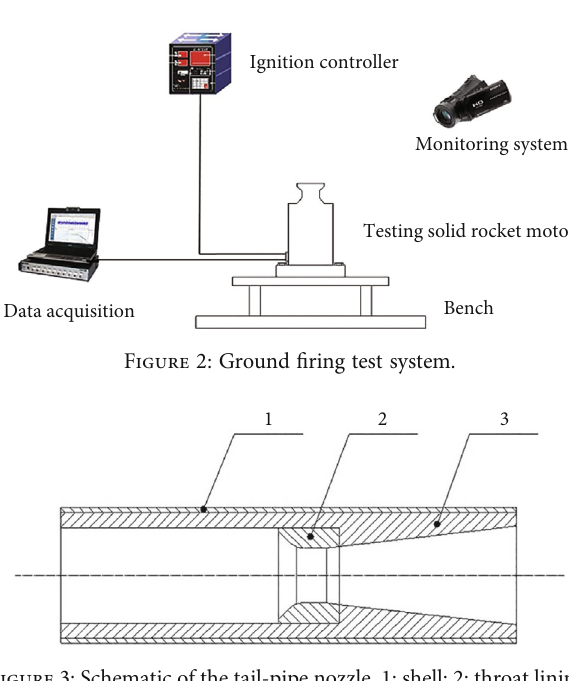
Figure 1: The original photograph of high silica/phenolic resin: (a) weak arrangement and (b) strong arrangement.